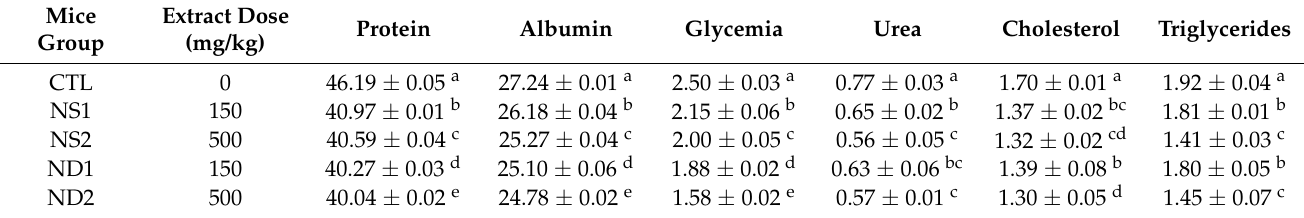
Table 5. Biochemical parameters of mice plasma treated with and without Nigella extract